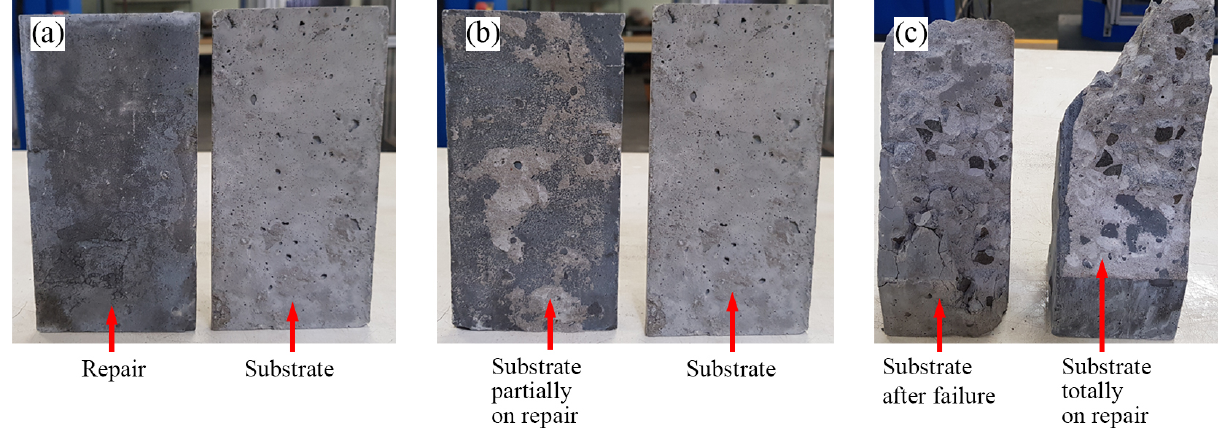
Figure 3. Typical failure modes: ( a ) failure mode A: adhesive failure; ( b ) failure mode B: mixed failure; ( c ) failure mode C: cohesive